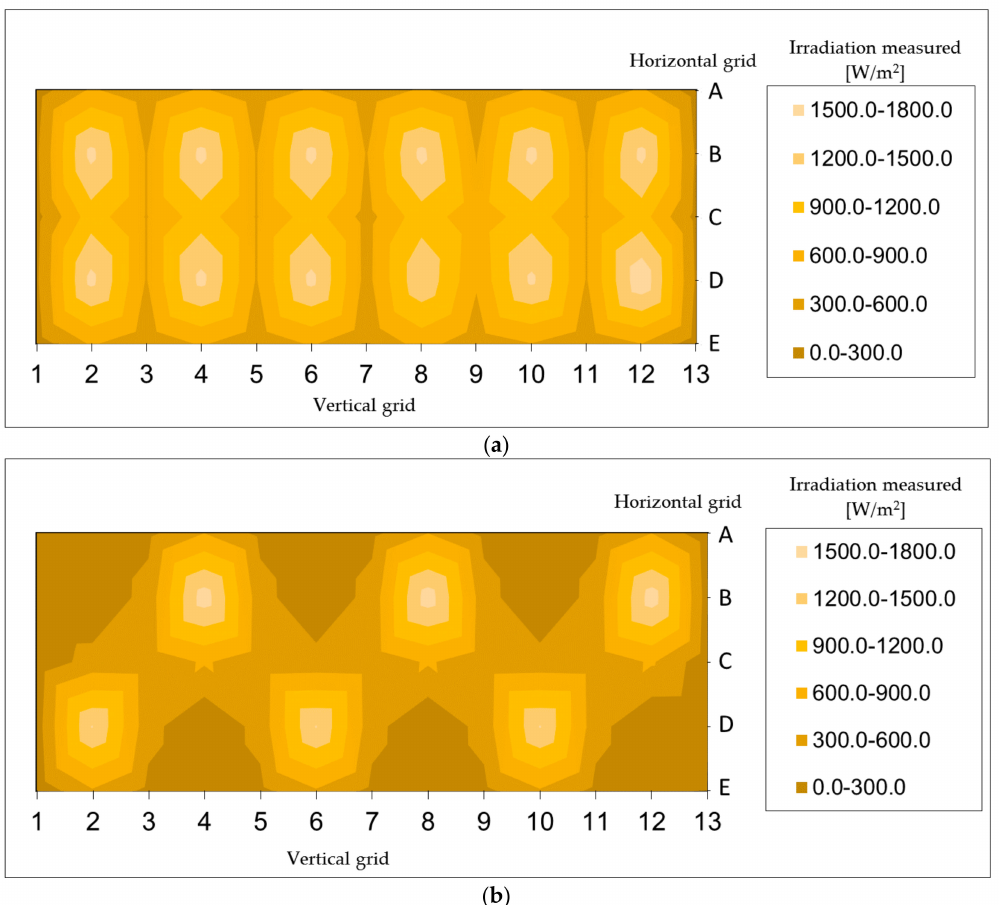
Figure 4. Irradiation measured on the knots of the grid ( a ) with all lamps; and ( b ) with only alternate